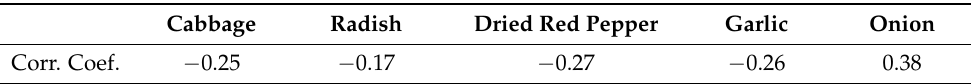
Figure 2. Annual Production of Major Field Crops in South Korea (in Ton). Source: Acreage and Production survey, Statistics Korea. ( a ) Cabbage; ( b ) Radish; ( c ) Dried red pepper, garlic, onion. Table 1. Correlation Analysis Results: Relationship between vegetable price volatility and its produc- tion in the following year. Cabbage Radish Dried Red Pepper Garlic Onion Corr. Coef. − 0.25 − 0.17 − 0.27 − 0.26